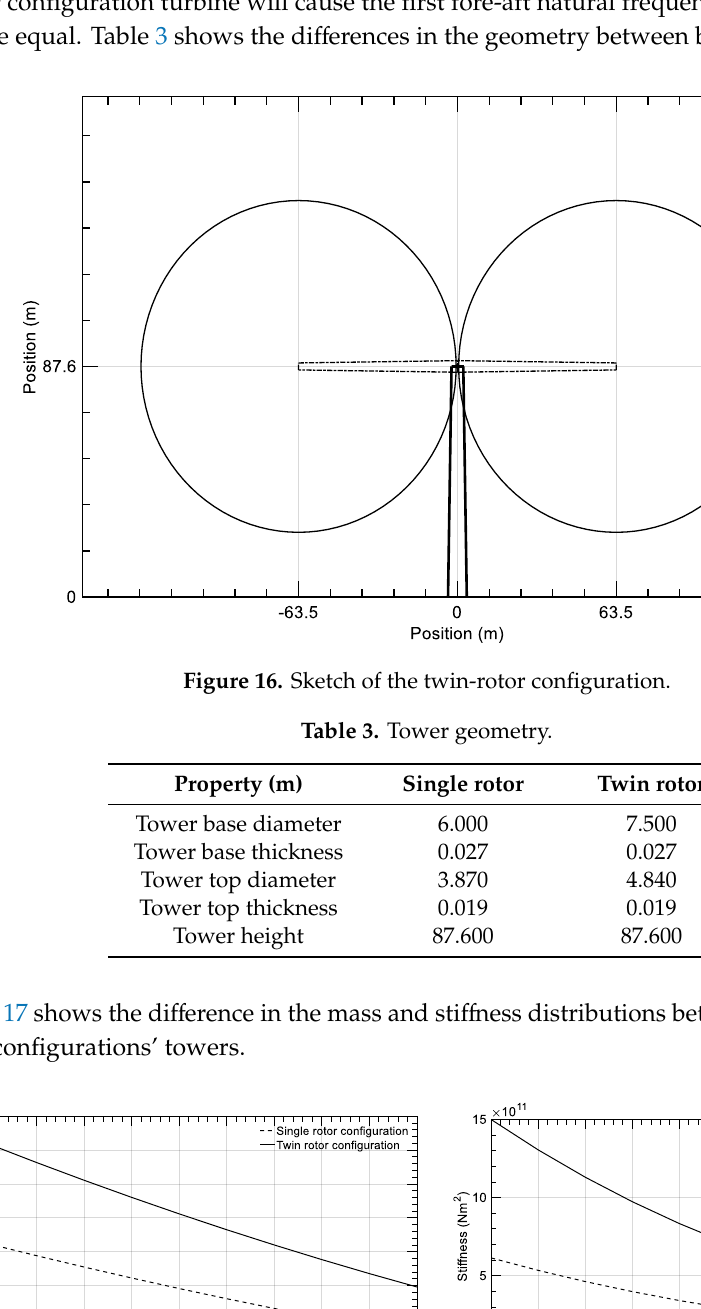
Figure 17. Tower structural properties: single rotor vs. twin rotor: ( a ) tower mass density distribution; ( b ) tower stiffness distribution.